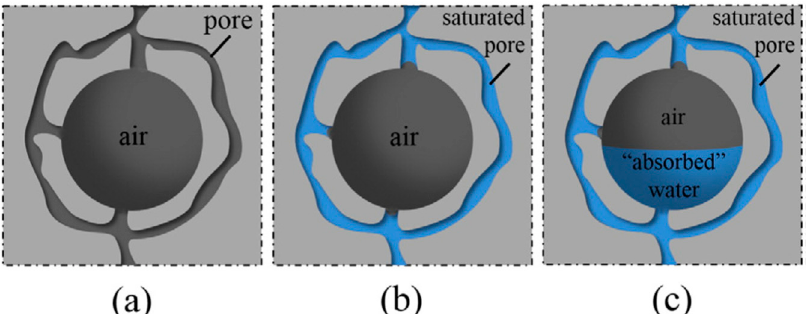
Figure 7. Schematic depicting capillarity and “absorption” of water by air diffusion [109]: ( a ) Before immersion in water;( b ) Before immersion in water;( c ) During freezing and thawing